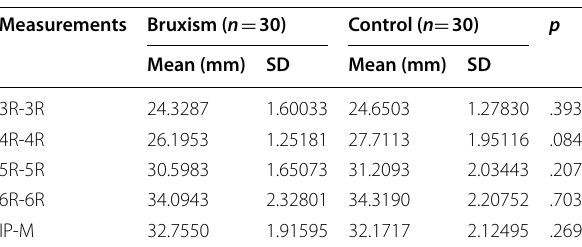
Table 2 Length and width measurements of the bruxism and control